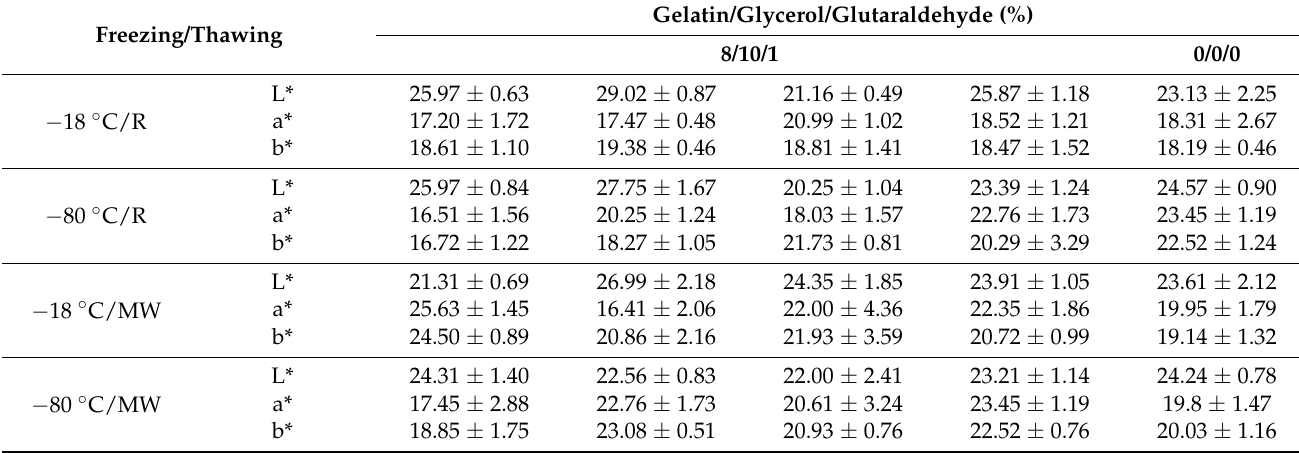
Table 8. Color values ± SD of meat with and without cross-linked coating depending on the method of freezing and